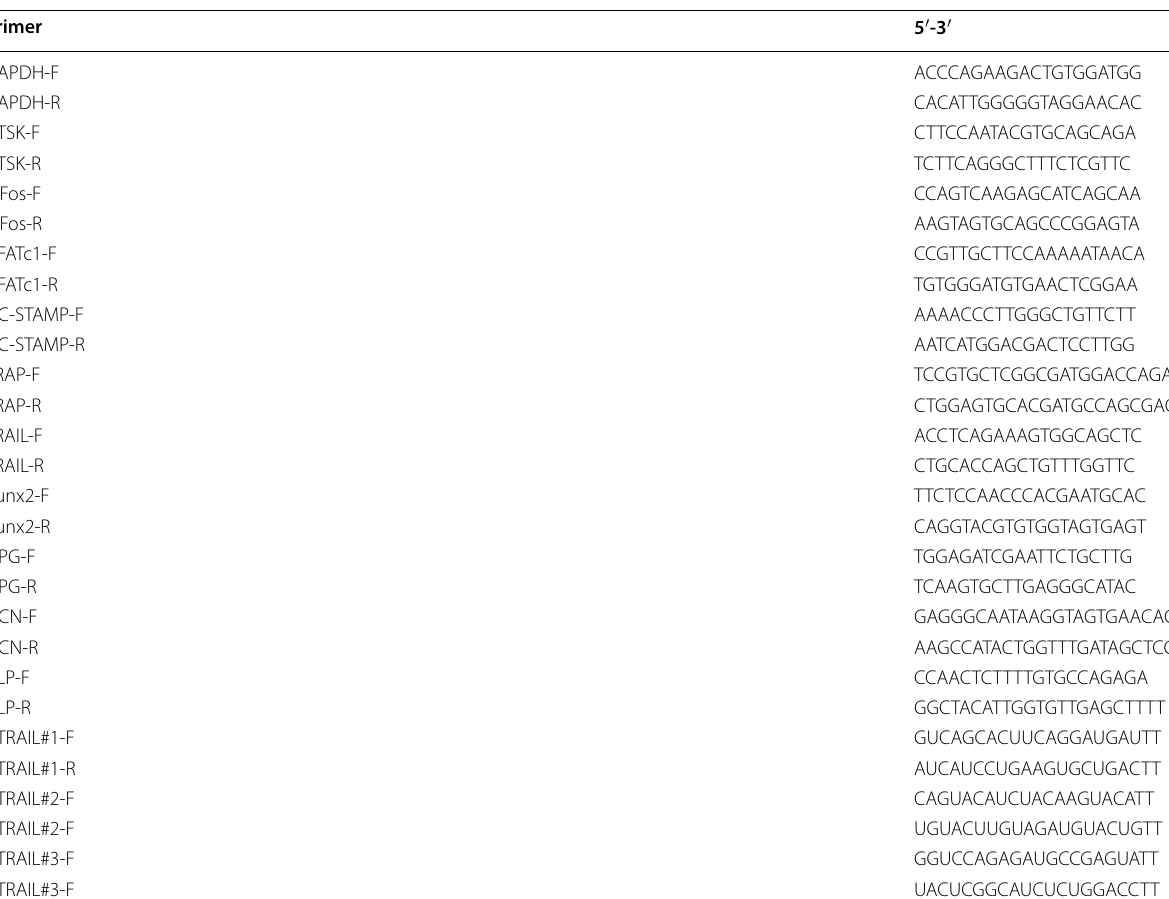
Table 1 Sequences of primers and siRNA Primer